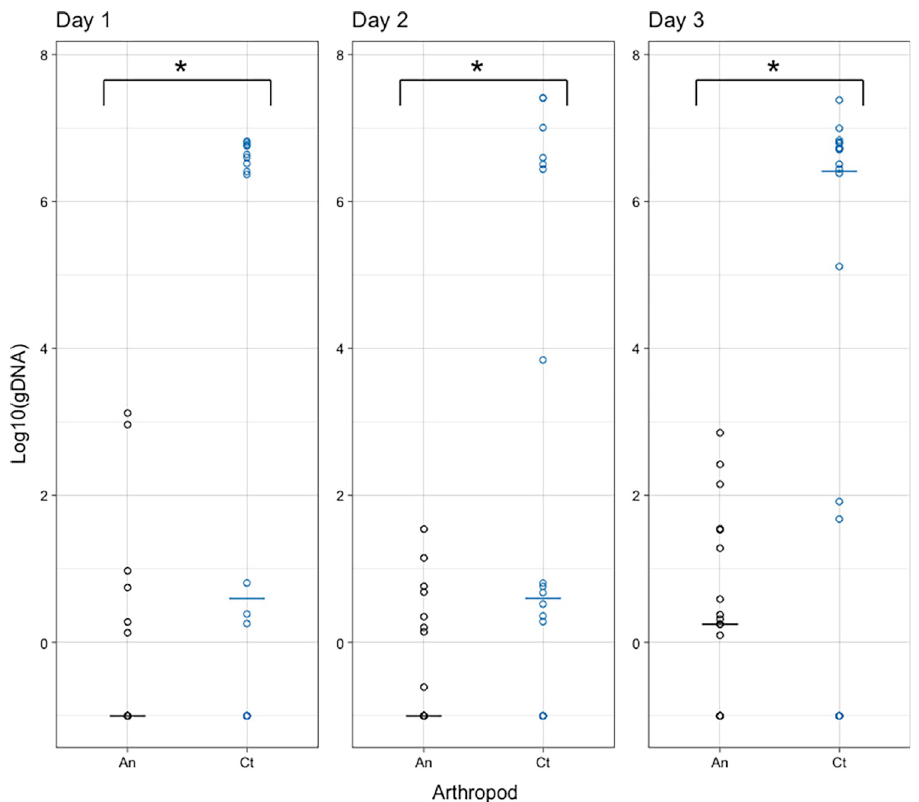
Fig 2. Concentration (log10) of rickettsiae from individual mosquitoes (black circles) who were infected via cofeeding with cat fleas (blue circles) at 1, 2, or 3 days of cofeeding (lines represent medians). There were significant differences in rickettsial load between the two arthropods (An = mosquitoes and Ct = cat fleas) at each timepoint, assessed by the Kruskal-Wallis test.